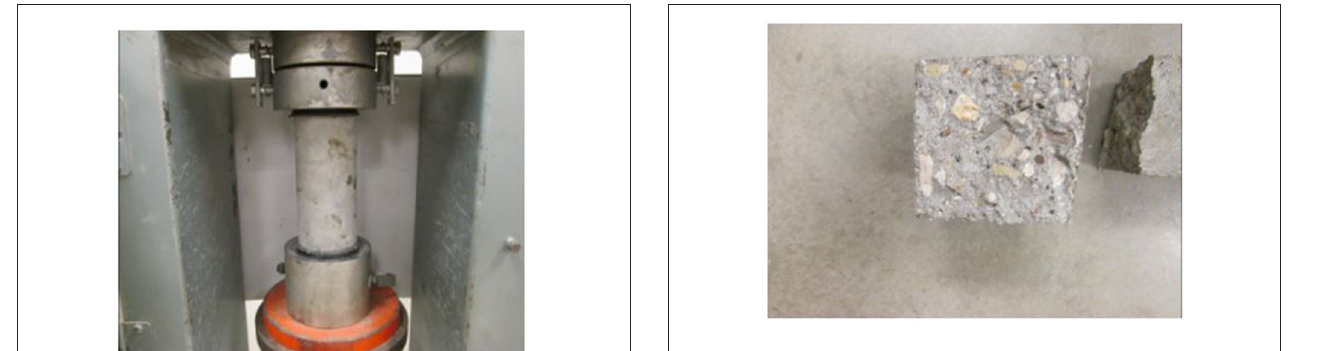
FIGURE 9 | Unlined (control) beam after to flexural